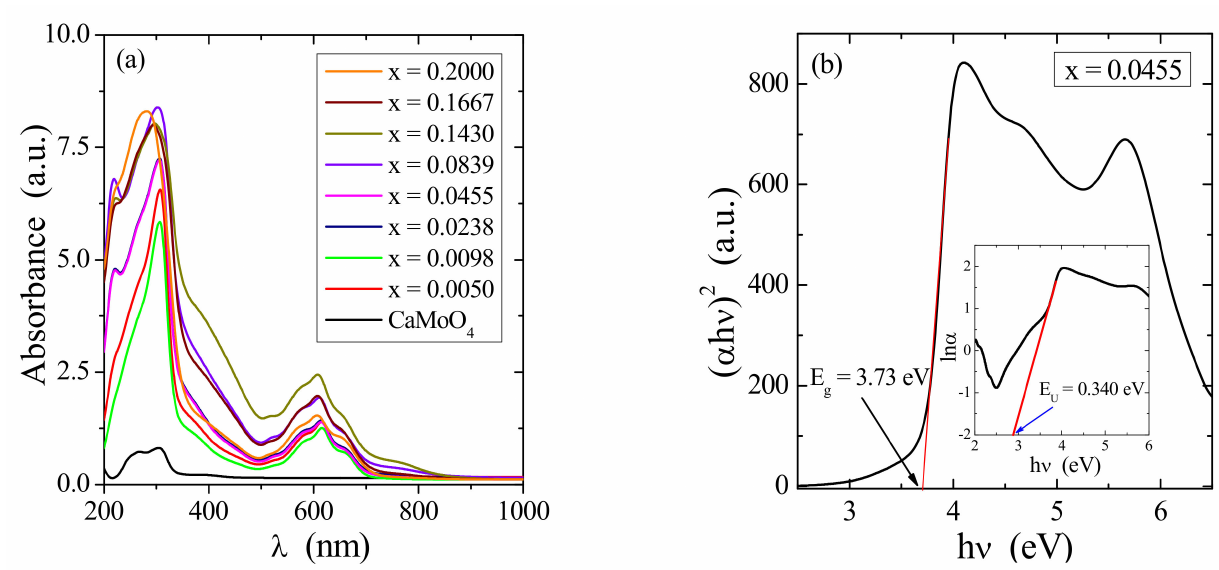
Figure 5. ( a ) UV–vis absorption spectra of CaMoO 4 and CCGMWO samples; ( b ) Plot of ( α h ν ) 2 vs. h ν for CCGMWO (x = 0.0455, y = 0.02) and determined band gap energy; (insert)—plot of ln( α ) vs. h ν for this sample and determined Urbach